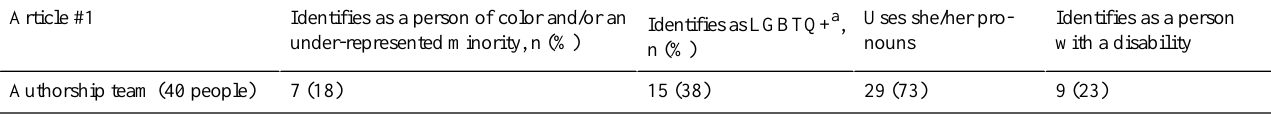
Table 1. Authorship team composition for article #1.